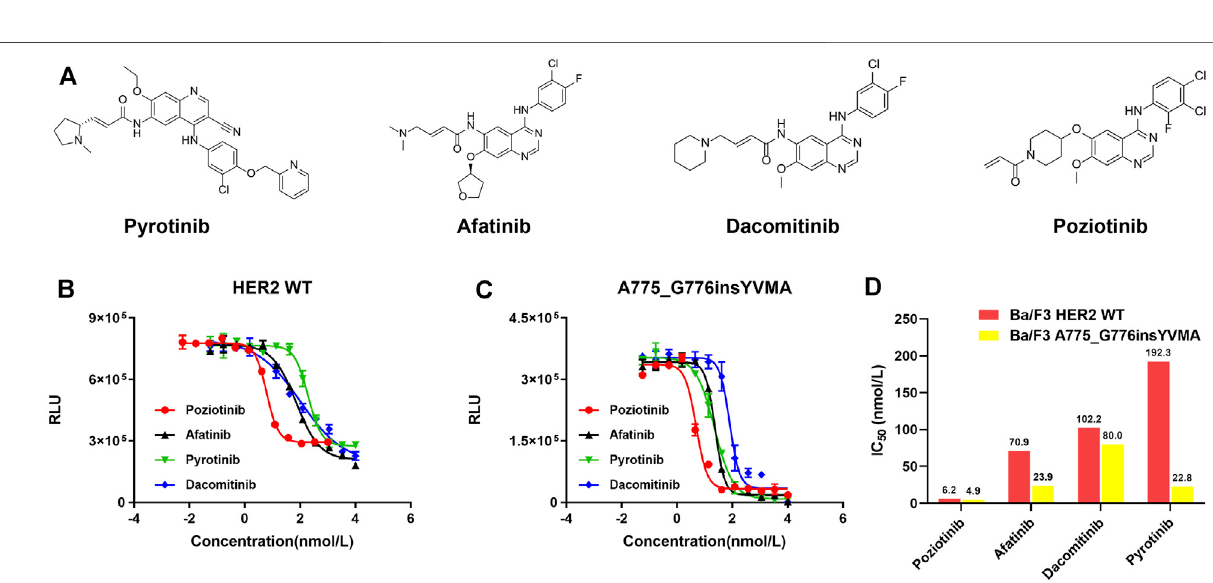
Frontiers in Pharmacology |